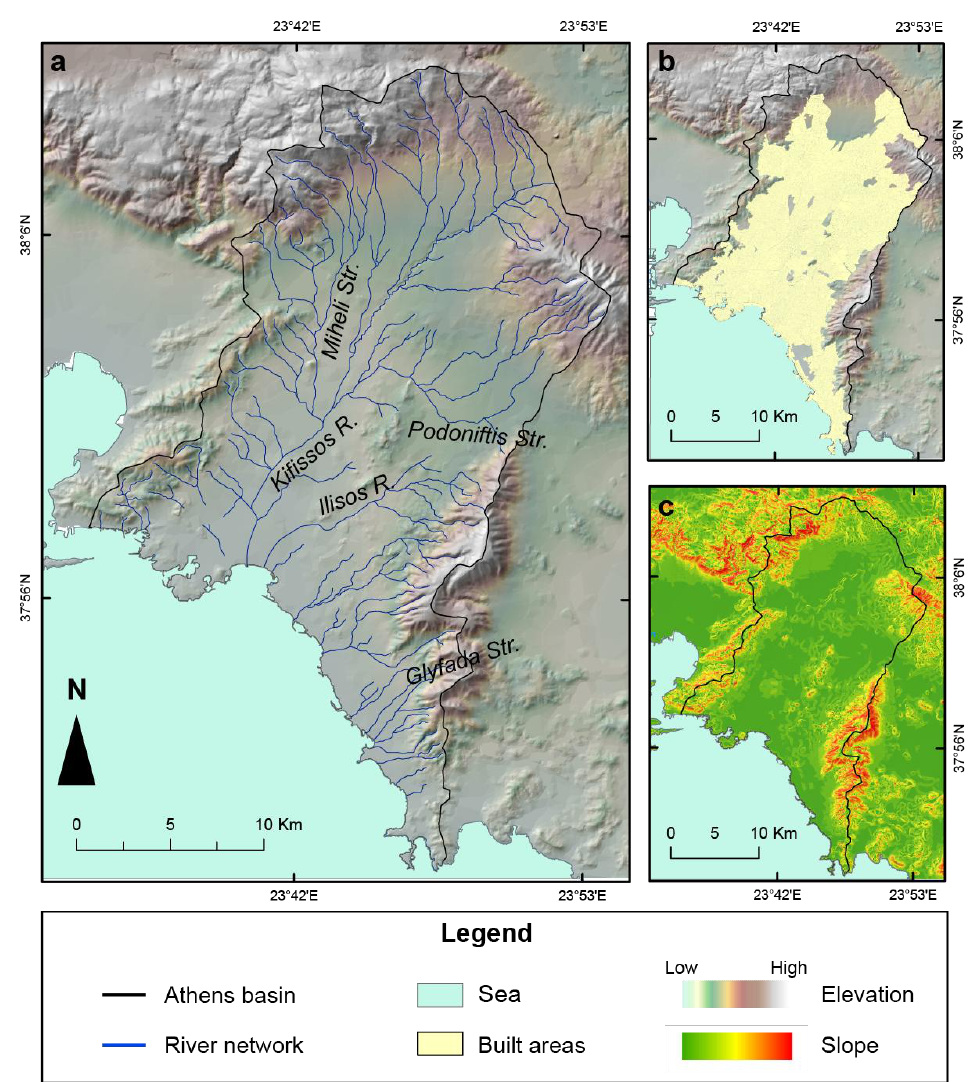
Figure 1. ( a ) Map of Athens basin showing the river network, ( b ) the built areas and ( c ) the slope gradient of the